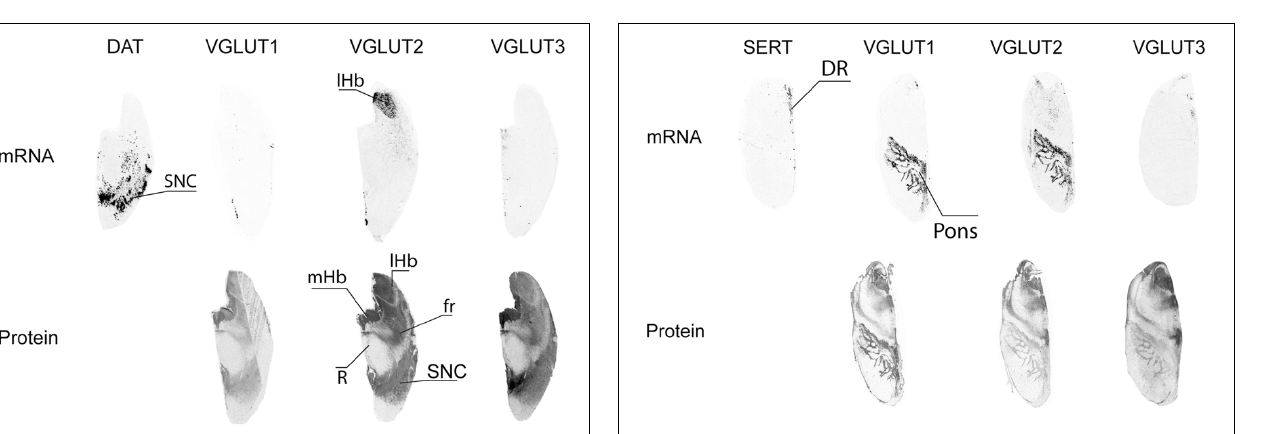
FIGURE 9 | Distribution of VGLUT1-3 mRNA and protein in the raphe. Serotoninergic cells in the dorsal raphe nucleus (DR) were identified by detection of the transcript coding for the serotonin transporter